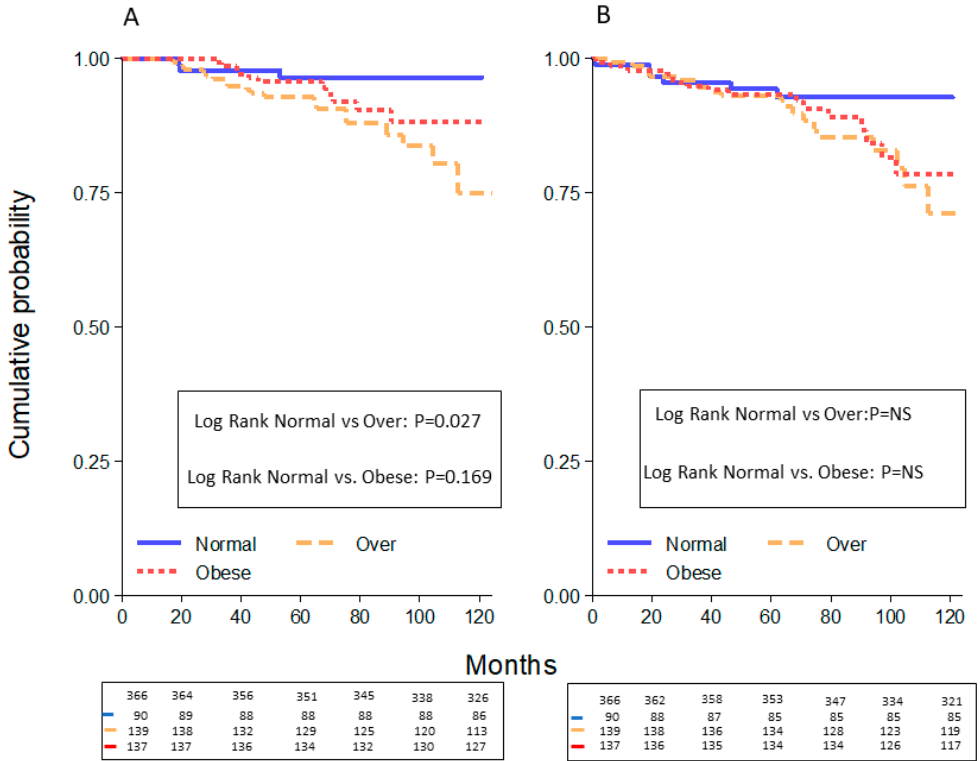
Figure 4. The five-year overall survival (OS) and progression free survival (PFS), excluding patients with follow-up less than 12 months and with second tumors, was calculated in the three groups of patients; The OS in normal weight plus underweight patients (blue line) was 96% whereas in the overweight group (orange line) it was 93% ( p = 0.027, HR 3.69, 95%CI = 1.17–13.4), and in the obese group (red line) it was 96% ( p = 0.169, HR 2.45, 95%CI = 0.68–8.78) ( A ). The PFS was equal to 94% in the normal/underweight group (blue line), 93% in the overweight (orange line), and obese patients (red line). No statistically significant difference was seen amongst the groups ( B ).